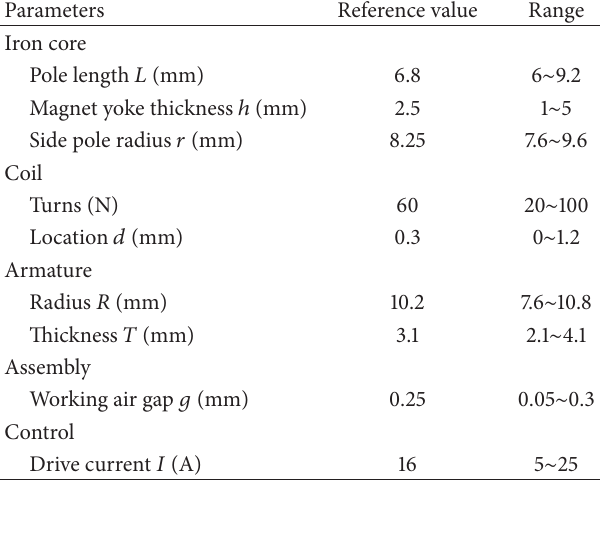
Table 2: Important parameters of model.